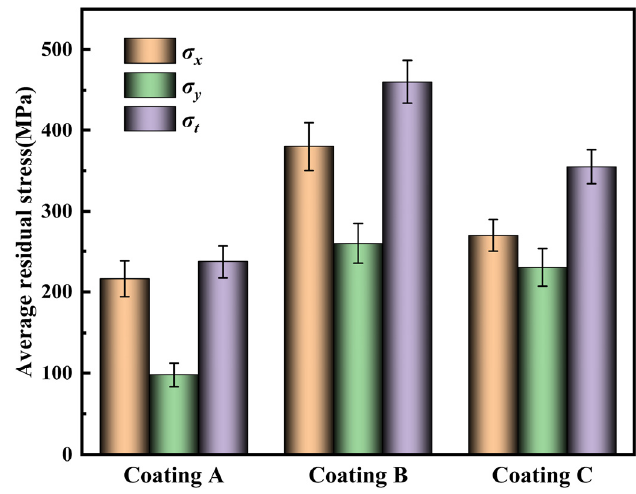
Figure 11. Average residual stress of different coatings.